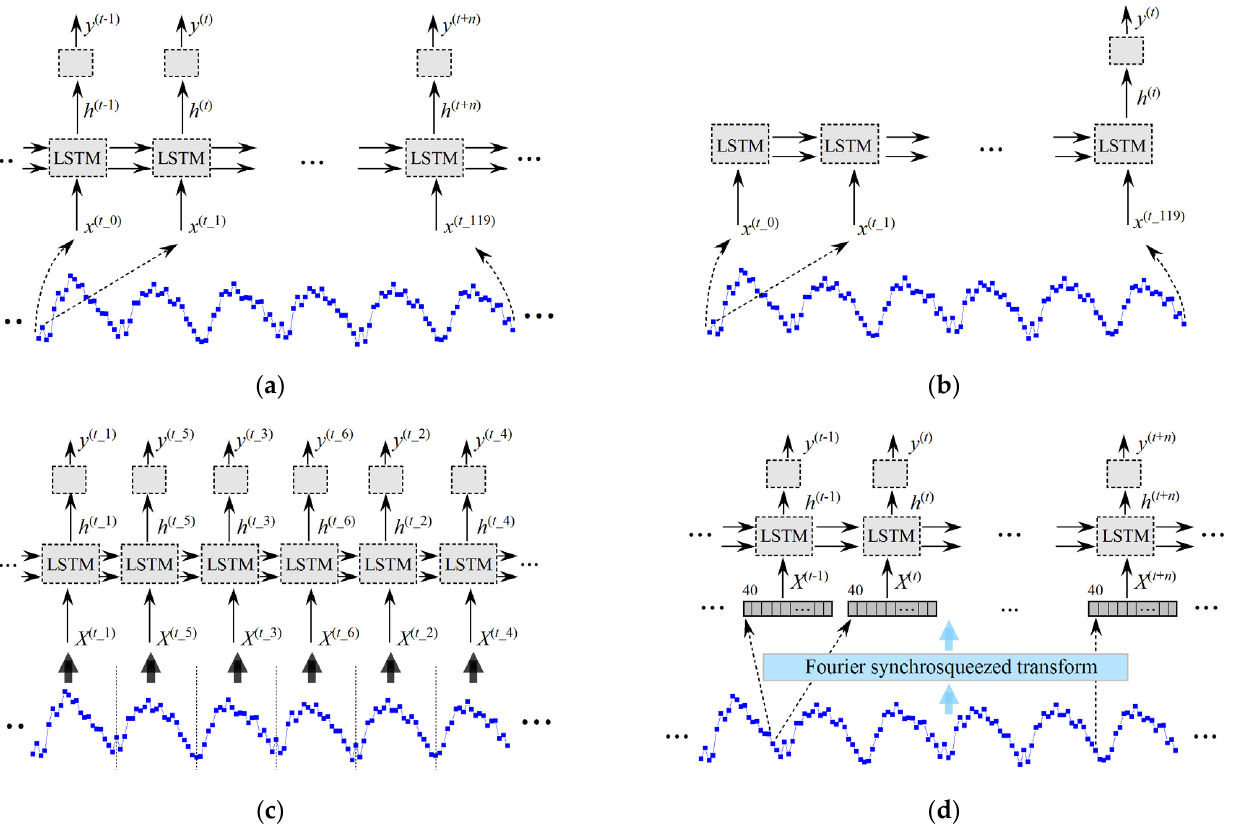
Figure 11. Different types of LSTM RNNs utilized in this paper. ( a ) LSTM with sequence inputs and sequence outputs. ( b ) LSTM with sequence inputs and last outputs. ( c ) LSTM with segment inputs and sequence outputs. ( d ) LSTM with segment inputs and sequence outputs. The basic parameters for these four types of networks are summarized in Table